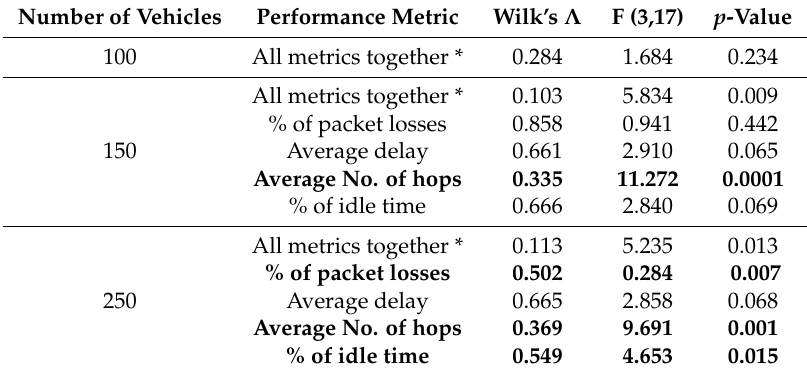
Table 2. MANOVA [37] results for the interaction test between the forwarding technique ( FT ) and the use of Tabu ( T ) for the forwarding phase of GHR. * The degrees of freedom in the F statistic are 12 and 8. If there is a significant interaction ( p -value < 0.05) in the “all metrics together” test, then interaction tests per metric need to be